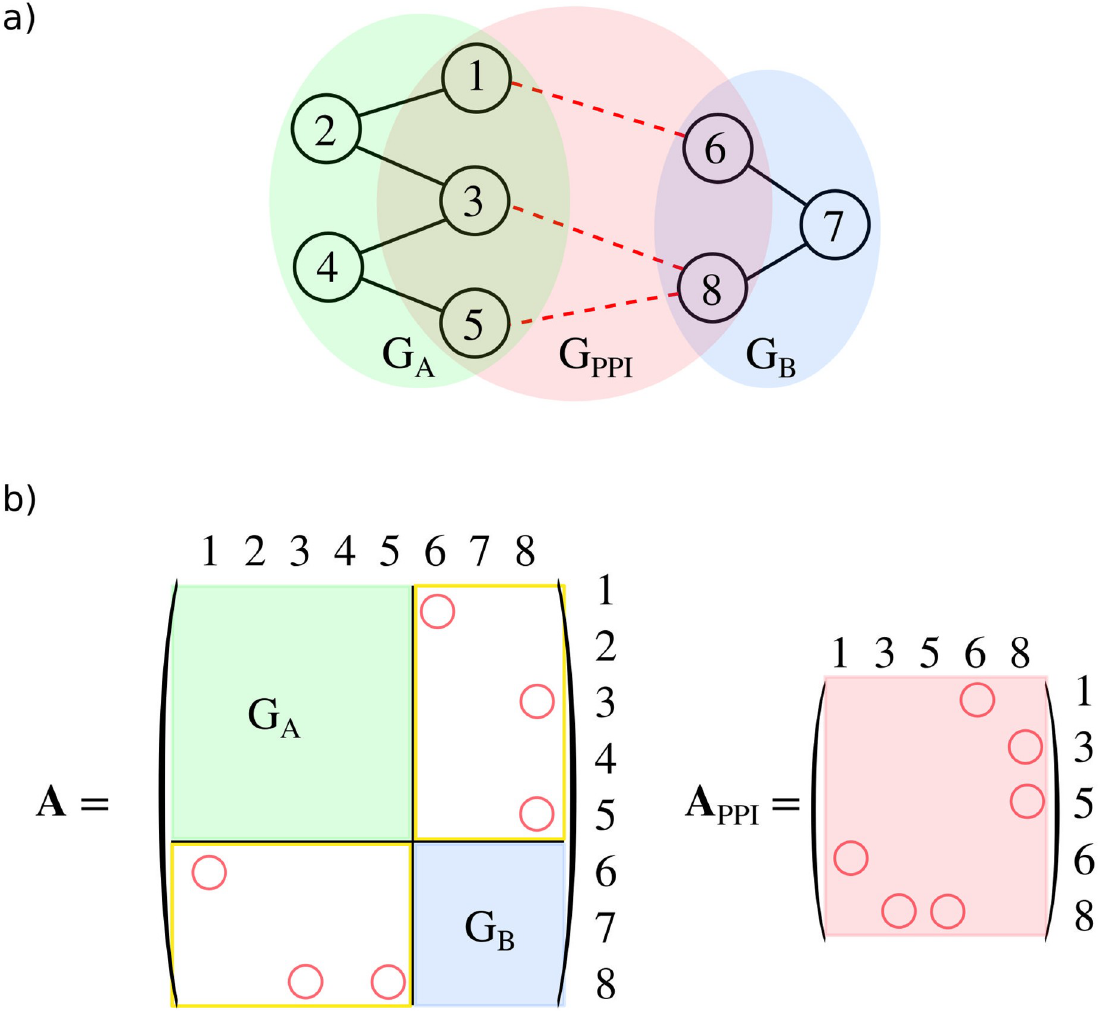
Fig 2. Subunits of the network. The PRN of the supersystem consisting of monomers A and B and the protein-protein interface (PPI): G = G A [ G B [ G PPI . G A and G B contain all nodes and edges within protein A and B , respectively. a) G PPI contains vertices from both monomers, but only those vertices, which have at least one edge connecting it to a vertex from the other monomer. The edges in G PPI are only those which connect the subgraphs G and G (dashed lines) and no edges within the subgraphs G A B graph. Part b) shows how blocks in the adjacency matrix A correspond to parts of G and the adjacency matrix A PPI of G PPI (circles indicating edges in G PPI